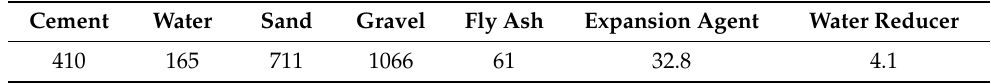
Table 1. Concrete proportion parameters (kg/m 3 ).